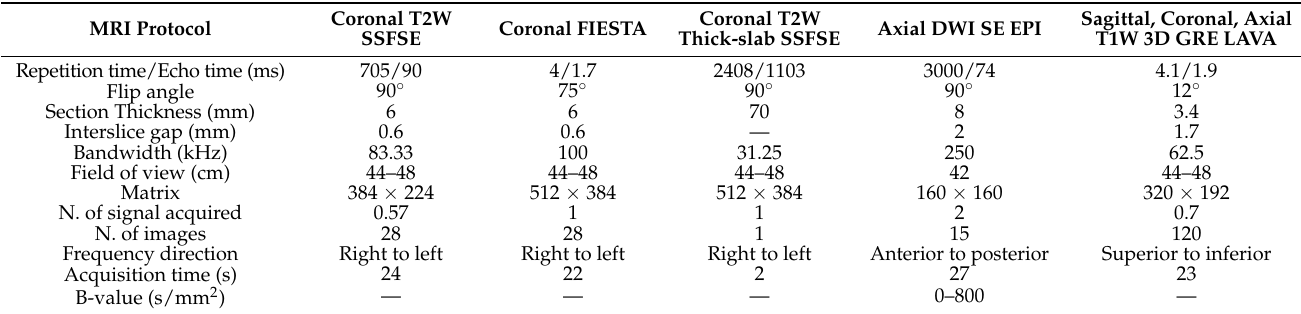
Table 1. MRE protocol. Synoptic table summarizes the scanning parameters of MR pulse sequences. Coronal T1-weighted 3D gradient-echo liver acquisition with volume acceleration (LAVA) sequences with fat suppression were acquired before and after intravenous administration of paramagnetic contrast material (0.1 mmol/kg, followed by 20 mL of saline solution, both at a flow rate of 2 mL/s); in particular, the sequence was acquired at 60 and 120 s after contrast administration. An anti-peristaltic agent, scopolamine-N-butyl bromide (Buscopan ® 20 mg; Boehringer Ingelheim, Milano, Italy), was administered intravenously just before post-contrast imaging to reduce peristaltic